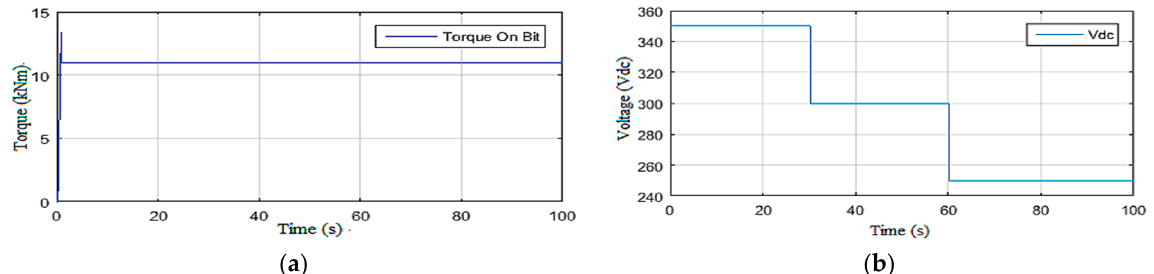
Figure 4. Inputs of Scenario 1: ( a ) the Tob; ( b ) the top drive voltage.